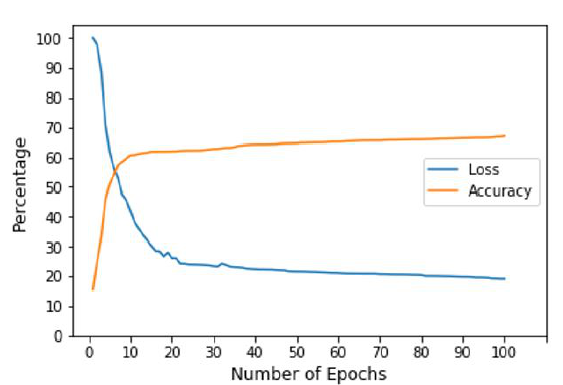
Figure 7. Graph showing loss (MSE)/accuracy vs. number of epochs (Dataset: 1.2K, Batch size: 20, number of Epochs = 100, Optimizer: Adam, loss = 19.11%, model accuracy =